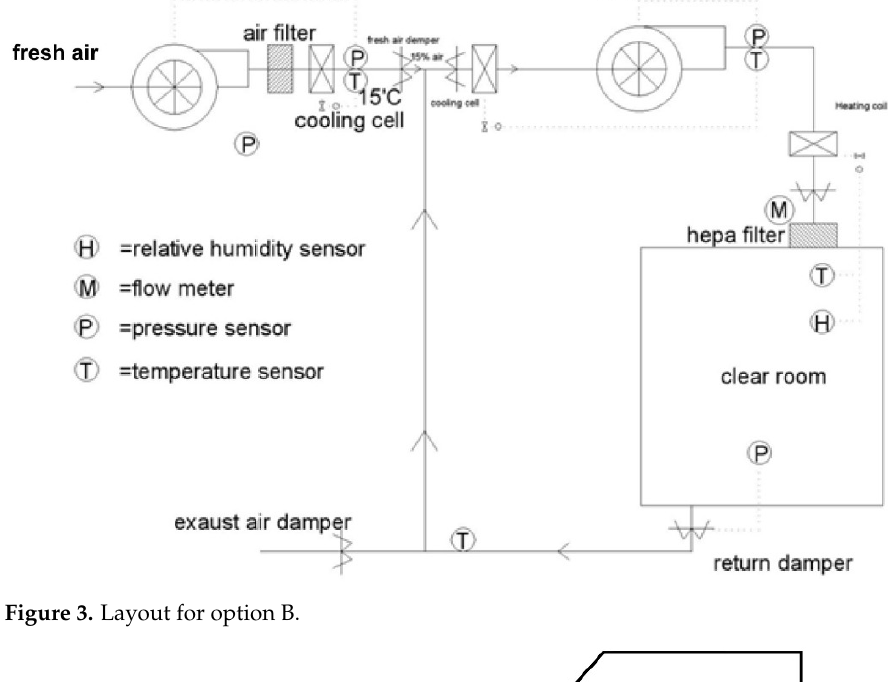
Figure 3. Layout for option B.